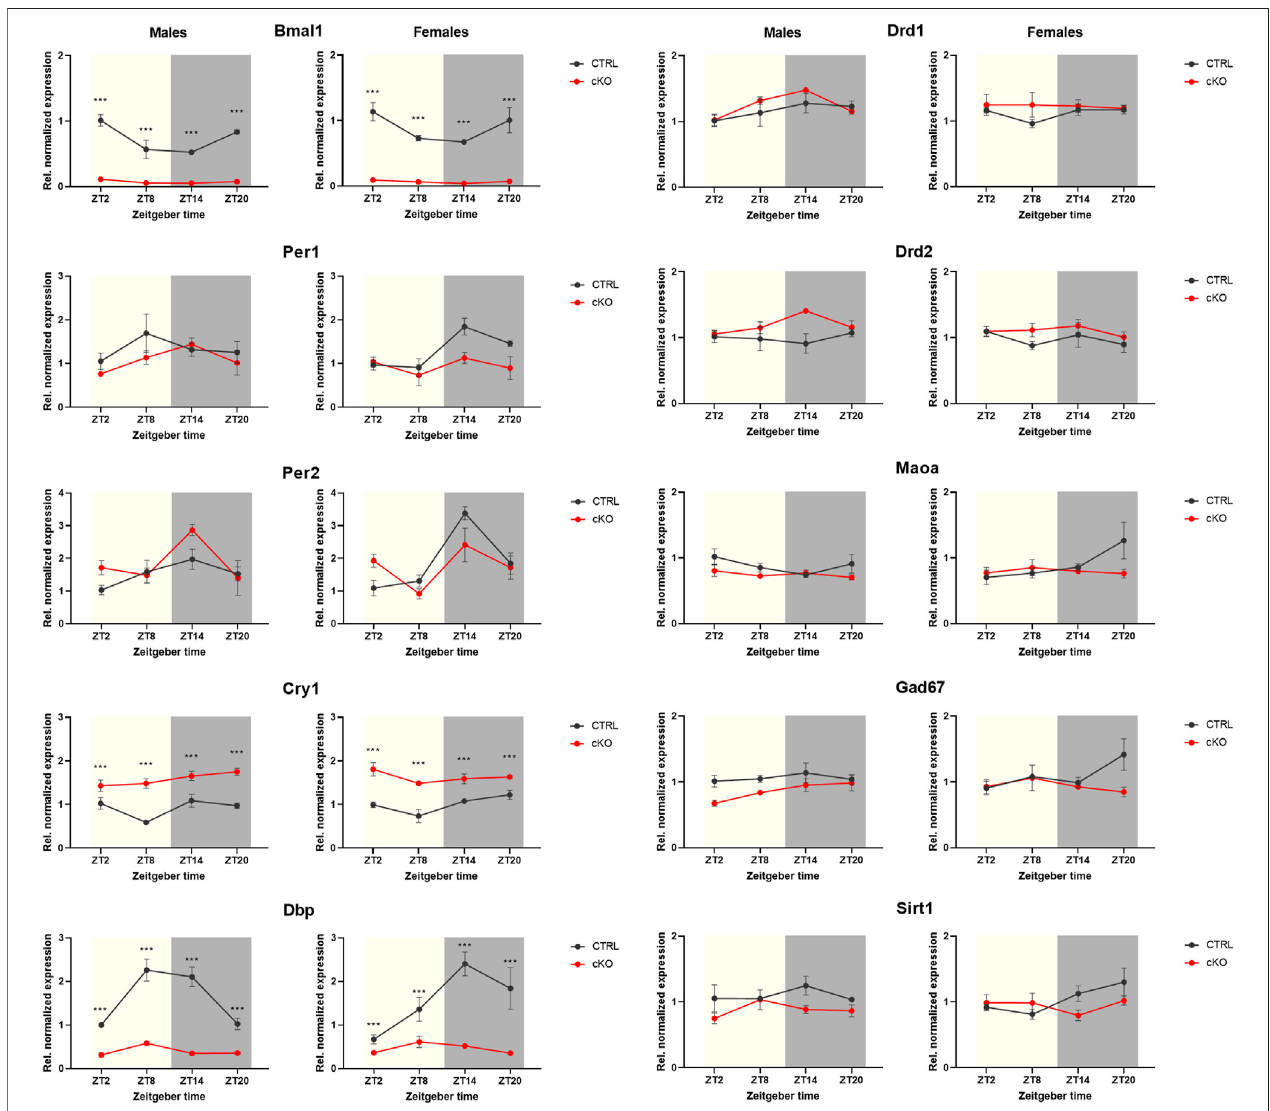
FIGURE 6| Gene expression analysis ofstriatal tissue collected from micewith a conditional Bmal1 knockout and control animals(n = 3 – 4 per genotype, sex, and time point). While expression of Bmal1 was abolished, it did only partially affect the expression of E-box-controlled genes. Whereas Per1 and Per2 gene expression remained largely unaffected, Cry1 expression was upregulated. Despite statistical analysis revealing genotype effects of targets of the dopamine and GABAergic signaling pathways in males, differences appeared to be relatively small between genotypes (for details, see result section and Table 4 ). Results are depicted as mean ± standard error of the mean